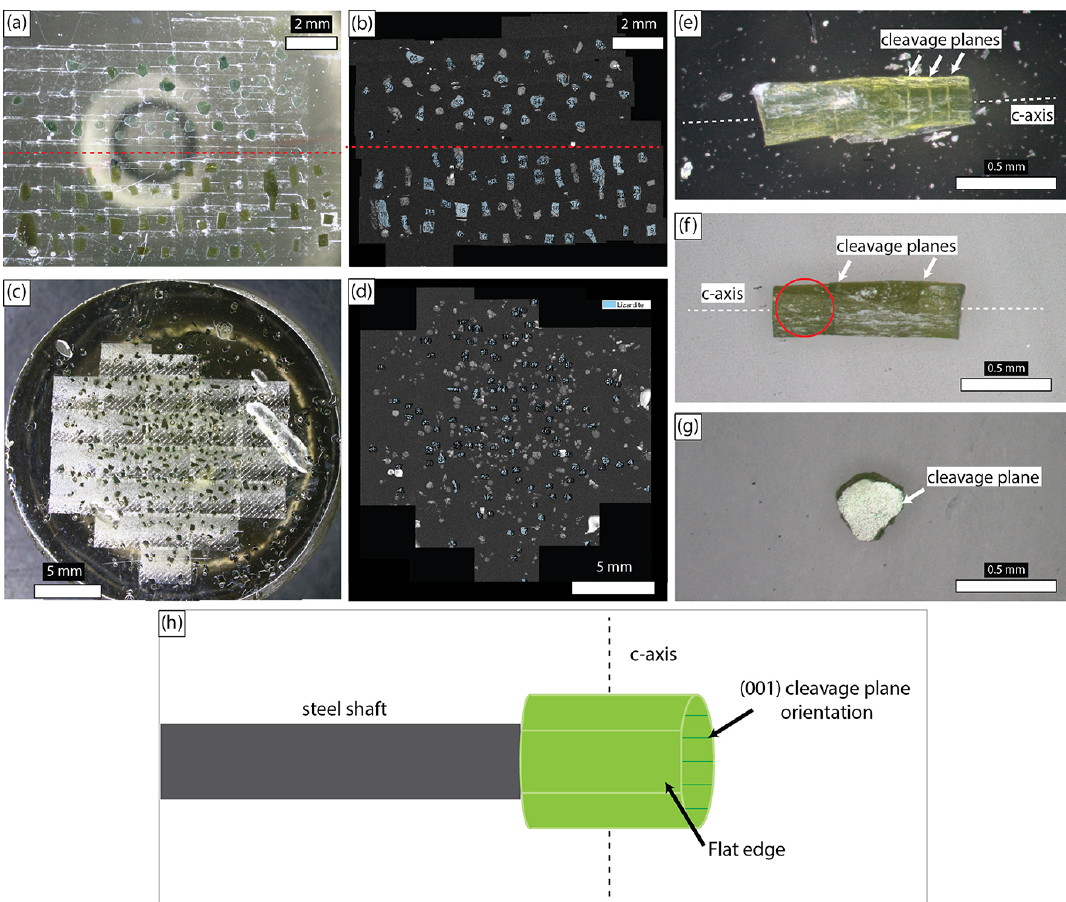
Figure 2. Single crystal epoxy resin grain mounts and single grains used for spindle study. (a) Photograph of oriented grain mount (OGM). (b) Forescatter detector scanning electron microscope (SEM) image of OGM with successfully indexed grains identified in blue. (c) Pho- tograph of random grain mount (RGM). (d) Forescatter detector SEM image of RGM with successfully indexed grains identified in blue. Panels (e) and (f) show single elongate grains with (001) cleavage planes (marked by white arrows) perpendicular to the grain elonga- tion. The red circle identifies the approximate location of the core drilled for single-crystal spindle study. (g) Flat platy grain showing face corresponding to (001) cleavage plane. (h) Schematic illustration of the single crystal grain spindle mount